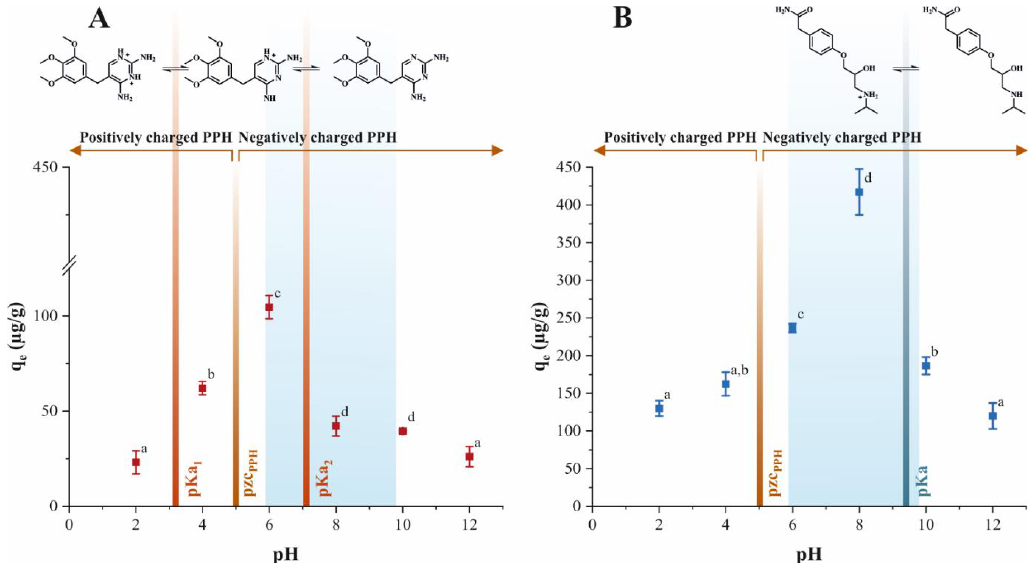
Figure 5. Effect of solution pH on the adsorption performance of ( A ) TMP ( ■ ) and ( B ) ATN ( ■ ) on PPH. The pH range of Indian water bodies (pH 5.9 – 9.8) is highlighted with the shadowed background. Different letters denote significant differences between experimental points ( p < 0.05, n = 3).